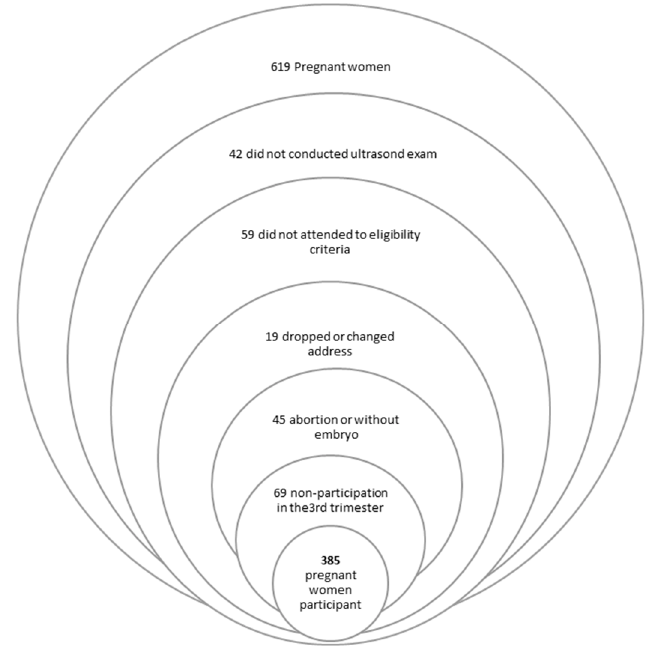
Figure 1. Description of the sample selection for ProcriAr study—São Paulo/Brazil, 2011–2013.